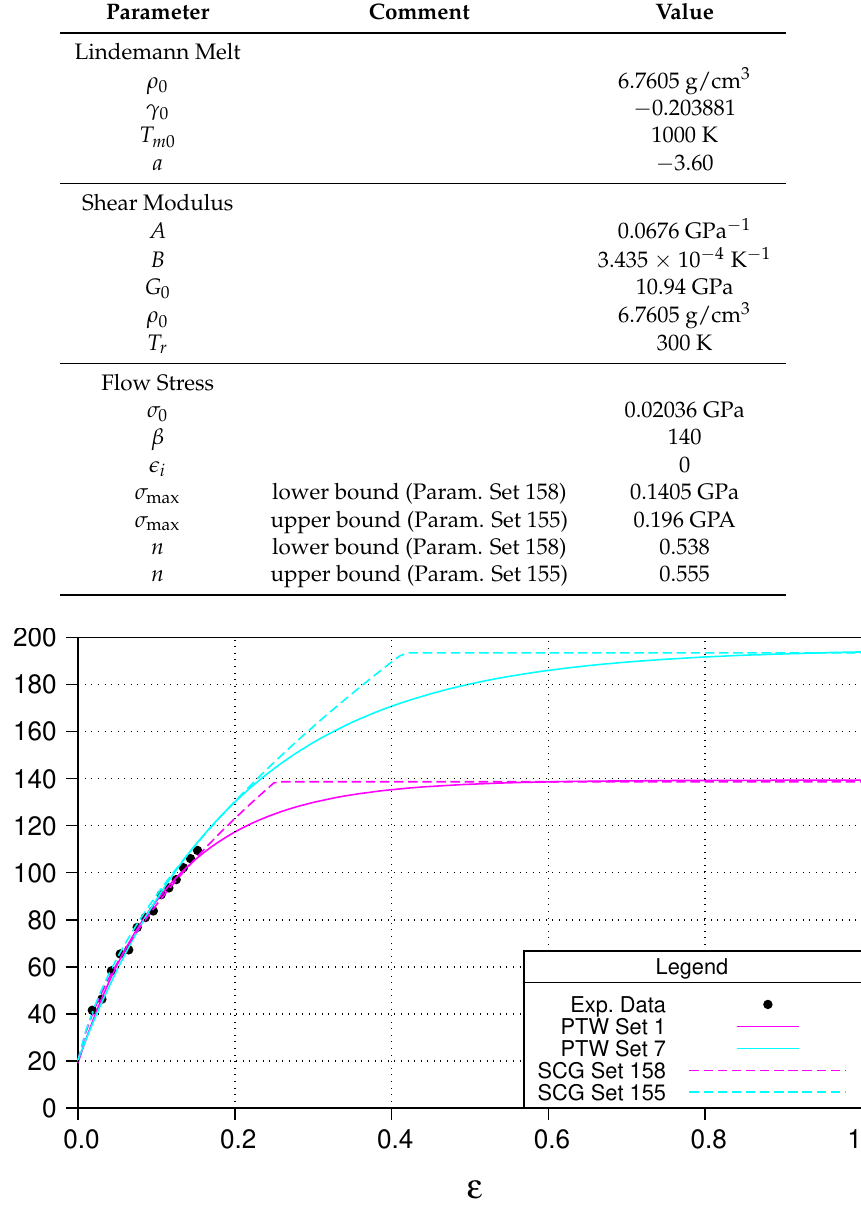
Figure 7. Flow stress as a function of